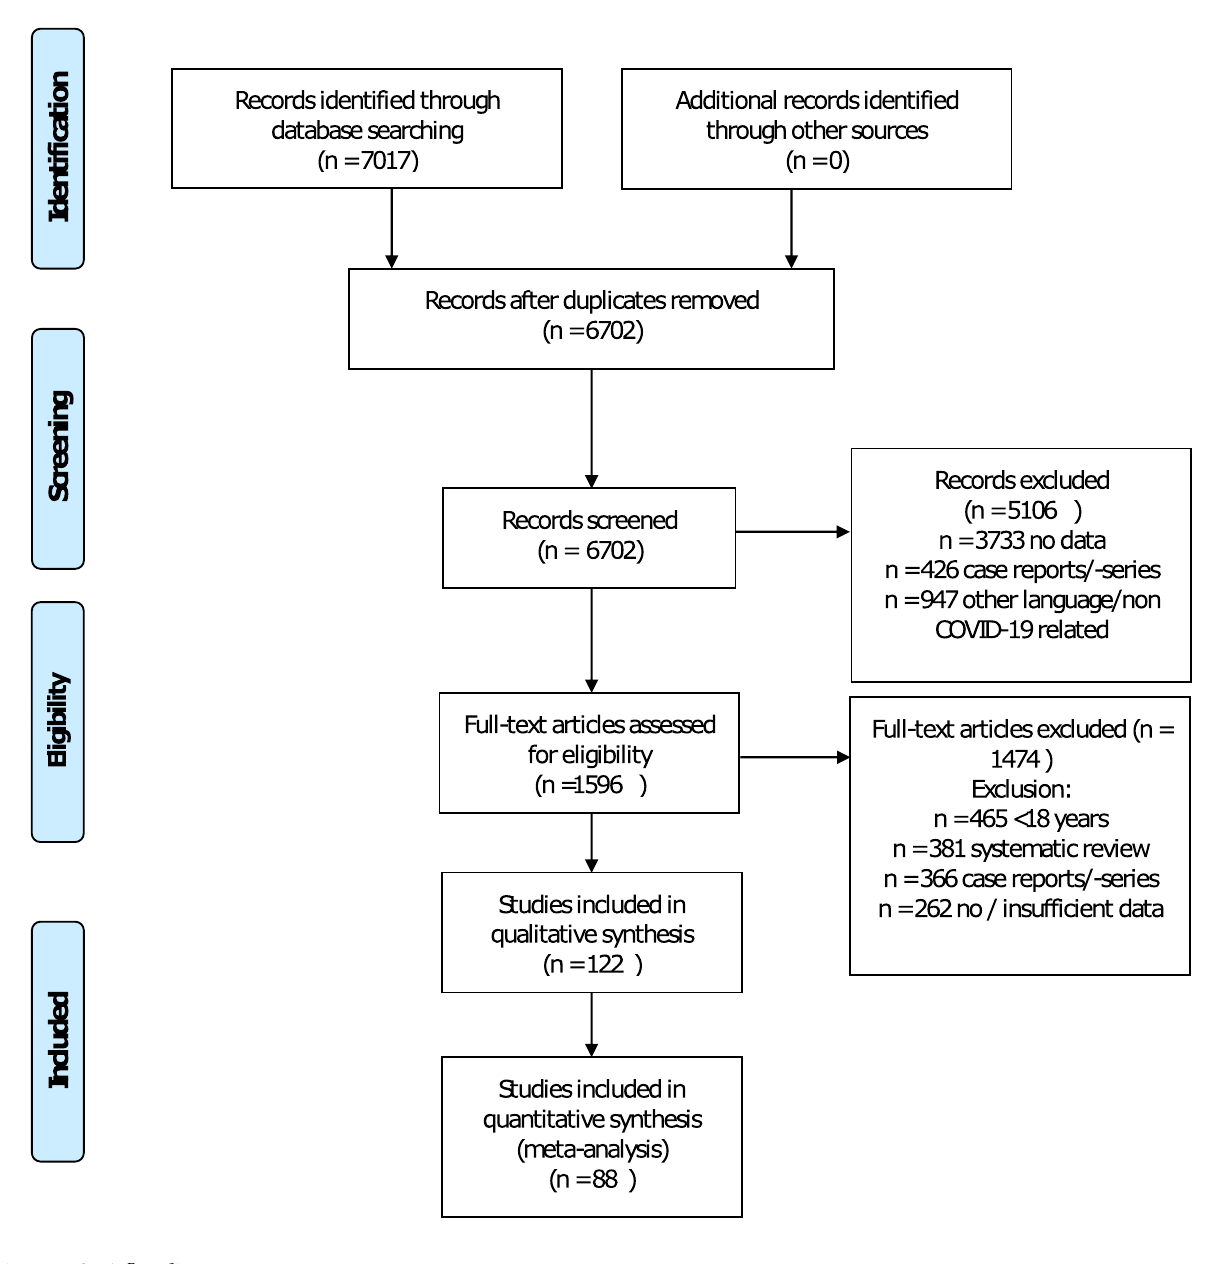
Fig 1. PRISMA flow